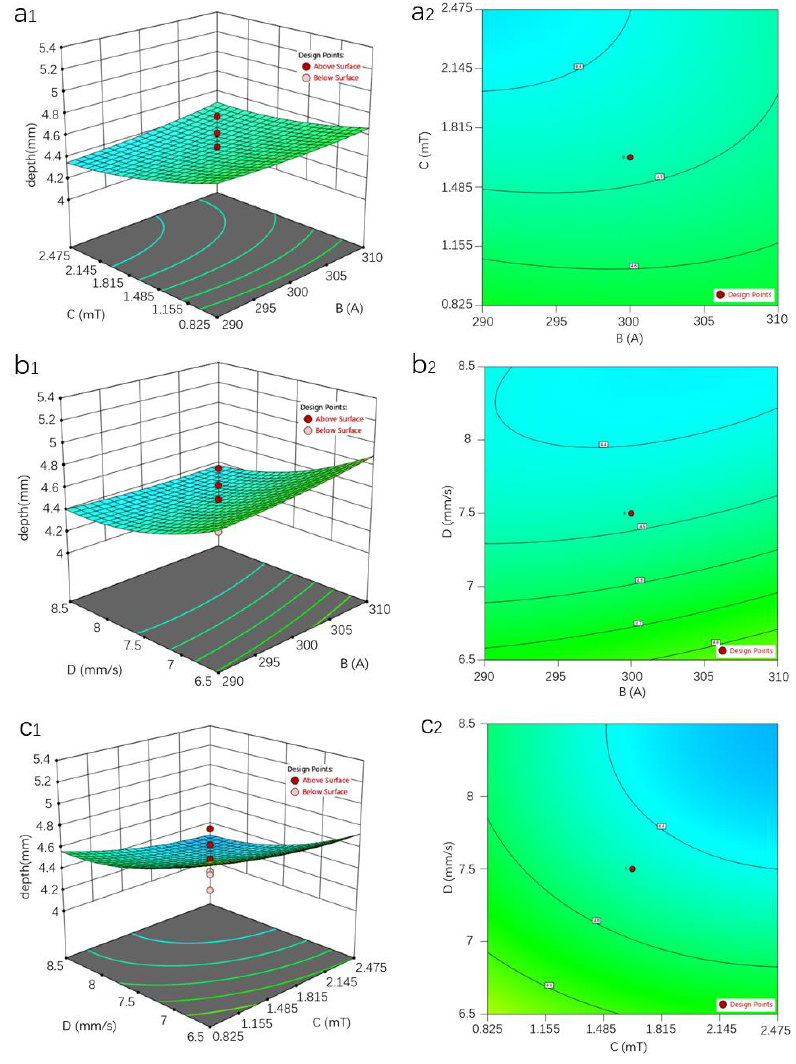
Figure 7. Interactive response surface and contour map of different factors: ( a 1 , a 2 ) are the interactive response surfaces and contour maps of B: MIG current and C: magnetic flux density, respectively; ( b 1 , b 2 ) are the interactive response surfaces and contour maps of factors B: MIG current and D: welding speed, respectively; ( c 1 , c 2 ) are the interactive response surfaces and contour maps of factors C: magnetic flux density and D: welding speed, respectively.